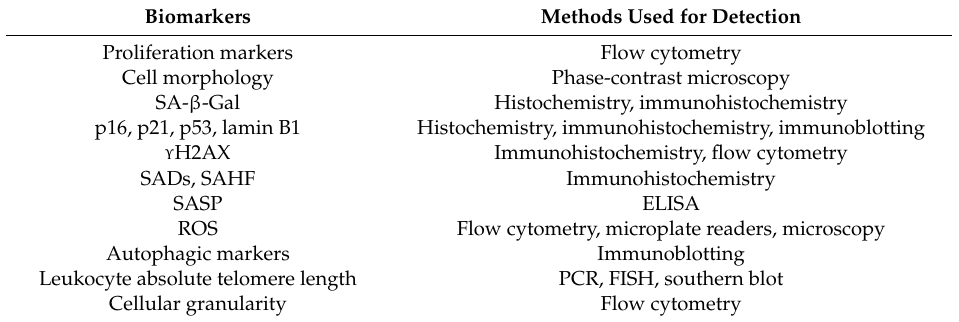
Table 2. Methodologies used for detection of the most common senescent cell biological markers.